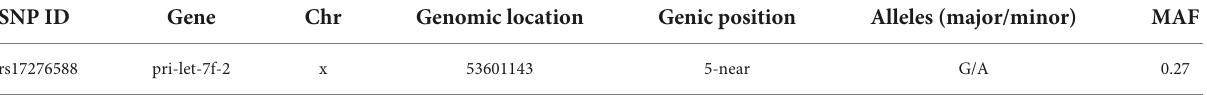
TABLE 1 Characteristics of the rs17276588 single nucleotide polymorphism (SNP) selected for the study.